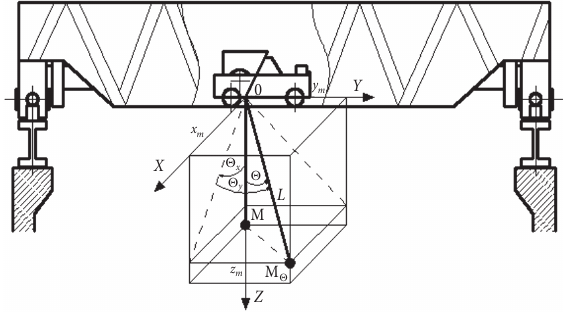
Fig. 1. The dynamic model of a